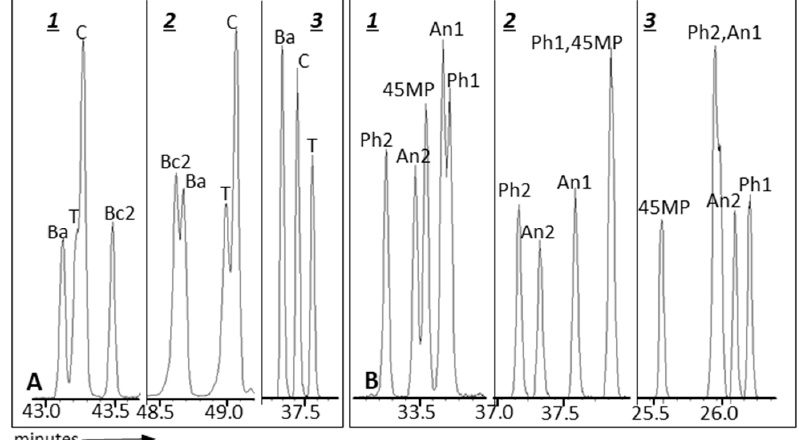
Figure 2. Elution order of 228-PAHs ( A ) and ethyl- anthracenes and phenanthrenes and 4,5- methylenephenanthrene ( B ) on phenyl arylene ( 1 ), 50% phenyl-polysiloxane ( 2 ) and SLB-ILPAH ( 3 ) stationary phases. For abbreviations see Table 2. Figure 3 shows that the best separation of 17 methylated benz( a )anthracenes, benzo( c )phenanthrenes and chrysenes isomers (228-C1) was achieved on the 50% phenyl- polysiloxane column; only seven isomers coeluted at more than 90% of the peak height while the remaining 10 isomers were at least partly resolved (Table 2). This separation was better than the separation achieved on the phenyl arylene column, where 11 of these isomers coeluted, as well as on the SLB-ILPAH column, where 10 of these isomers coeluted. The number of the observed coelutions might be reduced by increasing the lengths of the tested columns, reducing the internal diameters and/or by improving the applied temperature programs with stable temperature periods around the elution times of isomeric clusters. Figure 3. Elution order of methyl-benz( a )anthracenes, chrysenes and benzo( c )phenanthrenes and dimethylbenzo( c )phenanthrenes on phenyl arylene (1), 50% phenyl-polysiloxane (2) and SLB-ILPAH (3) stationary phases. For abbreviations see Table 2. The commercially available SLB-ILPAH column was 2/3 the length of the two other columns. The internal diameter was 3/4 of that of the other two and the film thickness 1/5 of that of the two other columns, which made the separation substantially faster. However, it is not possible to compare the dimensions of the IL column to the siloxane-based columns directly because of the different nature of an IL coating resulting in the different type of interactions between the analytes and the